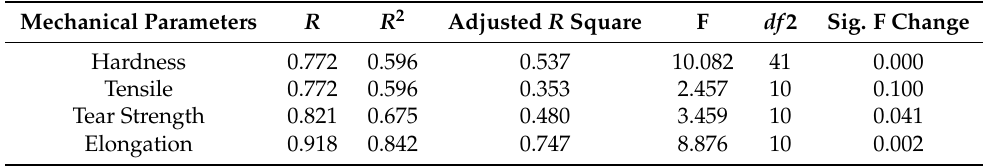
Figure 1. ( a ) line plot displaying means; standard deviation error bars and offset (+5—SiAu; +10—SiTTO; +15—SiMO; +20—SiTTOBAu; +25—SiMOBAu) for Shore A hardness samples. ( b ) line plot displaying means; standard deviation error bars and offset (+5 MPa—SiAu; +10 MPa —SiTTO; +15 MPa —SiMO; +20 MPa —SiTTOBAu; +25 MPa —SiMOBAu) for tensile strength samples; ( c ) line plot displaying means; standard deviation error bars and offset (+100%—SiAu; +200%—SiTTO; +300%—SiMO; +400%—SiTTOBAu; +500%—SiMOBAu) for elongation at break samples; ( d ) line plots displaying means; standard deviation error bars and offset (+5 kN/m —SiAu; +10 kN/m —SiTTO; +15 kN/m —SiMO; +20 kN/m —SiTTOBAu; +25 kN/m —SiMOBAu) for tear strength samples. Table 1. Regression summary of mechanical parameters.